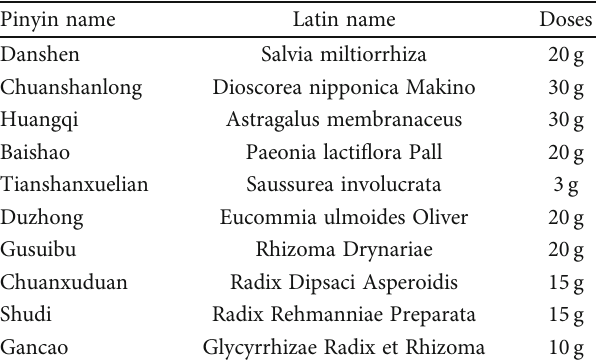
Table 1: Main components of